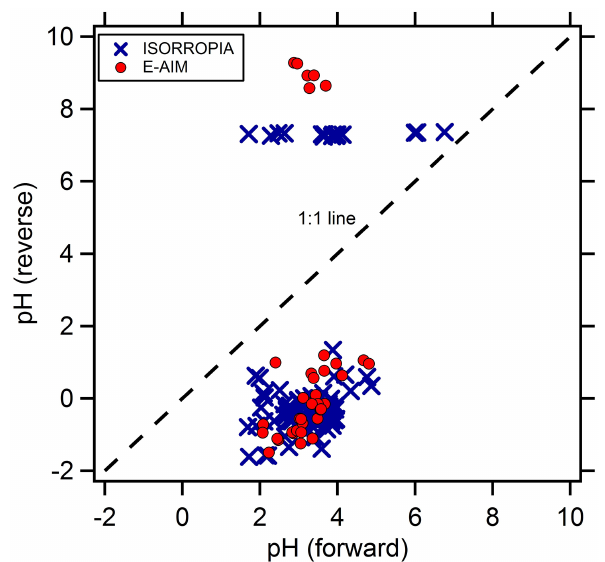
Figure 1. Comparison of pH predicted using the reverse and for- ward modes of ISORROPIA and